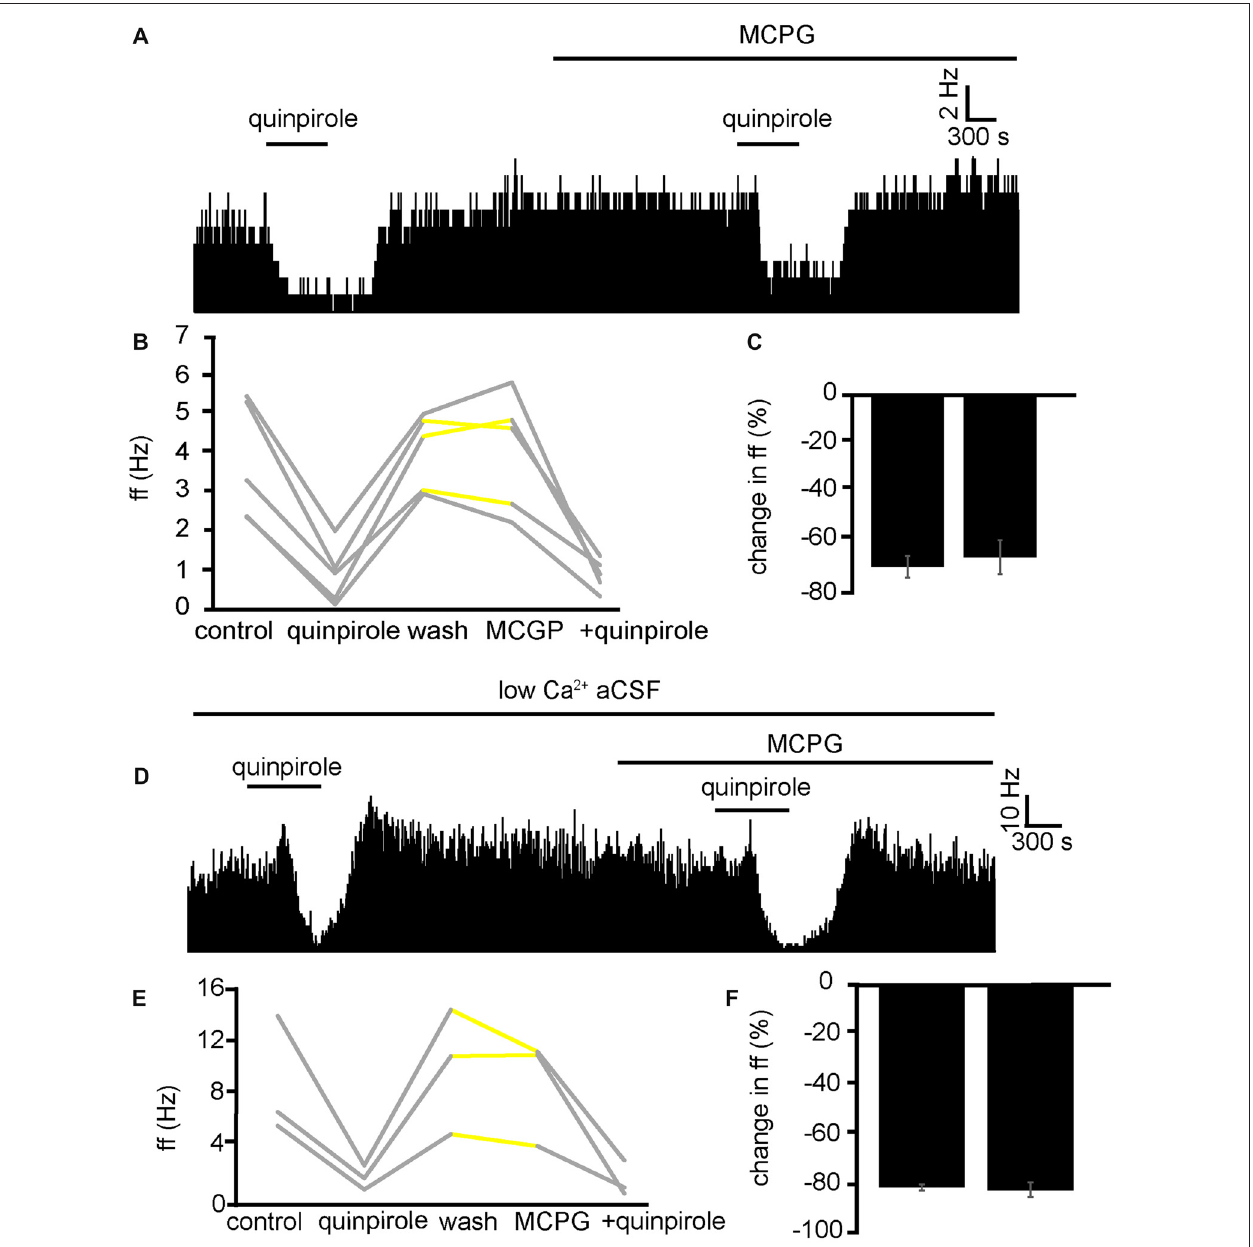
FIGURE 9 | Inhibitory effects of D2-like receptor agonists continue in the presence of mGluR antagonists and low Ca 2 + aCSF. (A) Inhibitory responses to quinpirole application alone and in the presence of MCPG. (B) Changes in firing frequency for five VP neurons to application of quinpirole and quinpirole in the presence of MCPG, similar to that illustrated in panel (A) . Firing frequency was measured before the application of quinpirole, during the application of quinpirole, after wash out of quinpirole, during application of MCPG and finally during the application of quinpirole in the presence of MCPG. Responses characterized by significant ( P < 0.05) changes in firing frequency are in gray, the other ones in yellow. (C) Firing frequency in response to quinpirole compared to quinpirole in the presence of MCPG. (D) Inhibitory responses to quinpirole application in the presence of low Ca 2 + aCSF are repeated in the presence of low Ca 2 + aCSF and MCPG. (E) Changes in firing frequency for three VP neurons to application of quinpirole and quinpirole in the presence of MCPG, similar to that illustrated in panel (A) . Firing frequency was measured; before the application of quinpirole, during the application of quinpirole, after wash out of quinpirole, during application of MCPG and finally during the application of quinpirole in the presence of MCPG. Responses characterized by significant ( P < 0.05) changes in firing frequency are in gray, the other ones in yellow. (F) Firing frequency in response to quinpirole in low Ca 2 + aCSF compared to quinpirole in the presence of low Ca 2 + aCSF and MCPG.